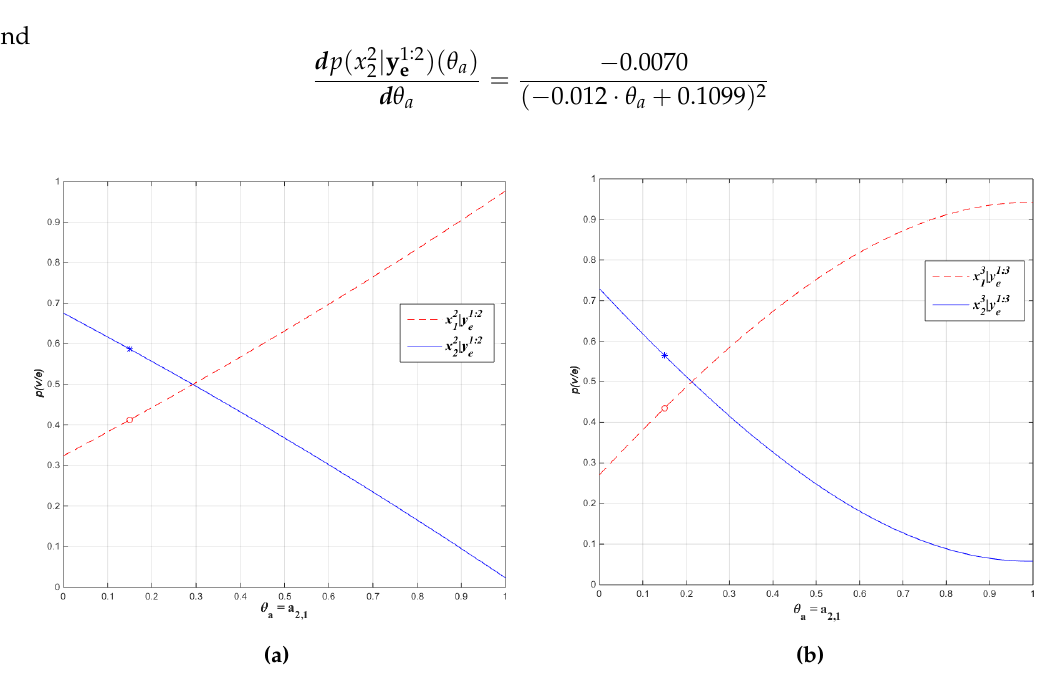
)( θ a ) for both states of X 2 . ( b ) p ( X 3 | y 1:3 e